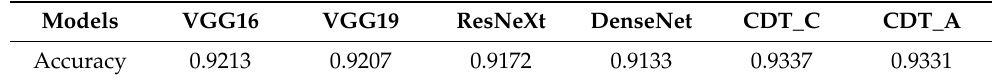
Table 3. Accuracies of CDTNet and other models on FMNIST.